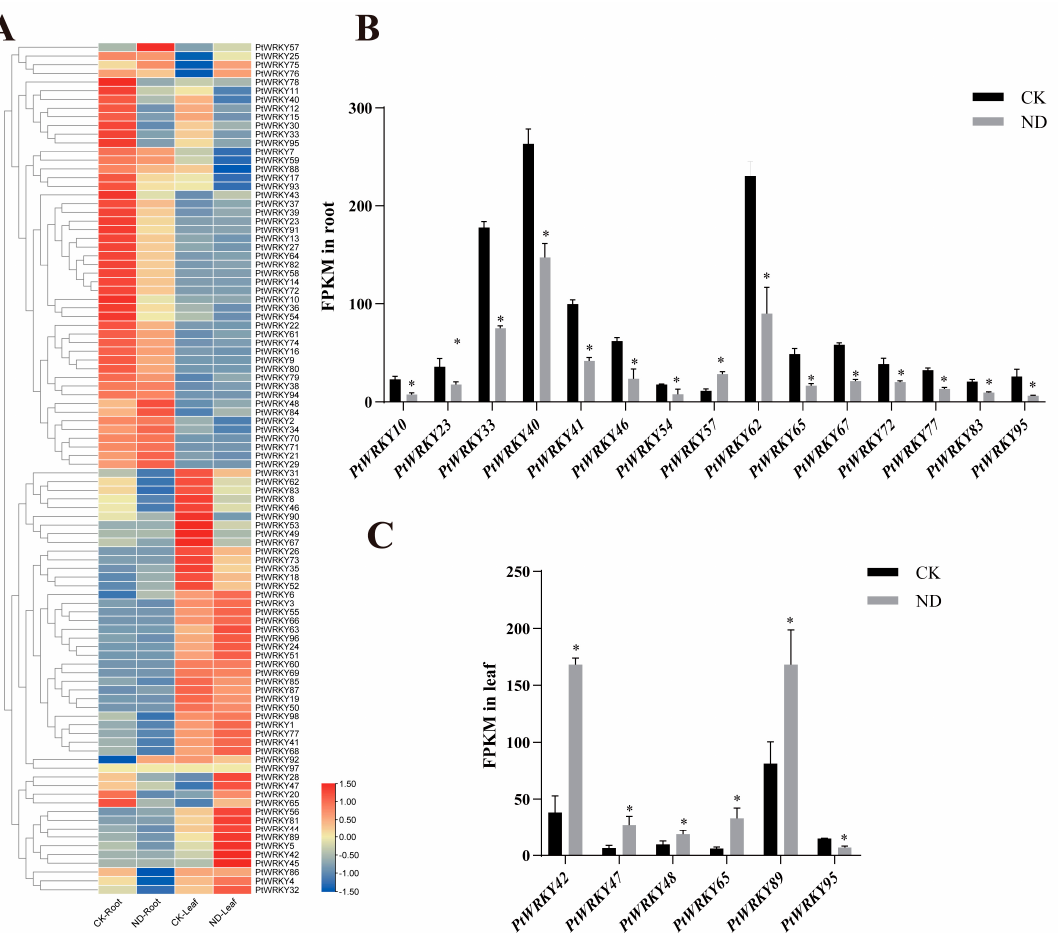
Figure 7. PtWRKYs transcription expression level under LN. Heat map of PtWRKYs expression obtained from transcriptome sequence data ( A ). Differently expressed PtWRKYs in poplar roots ( B ) or leaves ( C ). CK, the control group; ND, the nitrogen deficiency group. According to independent sample t -test results, “*” indicated significant difference in gene expression compared with control (CK) ( P ≤ 0.05).